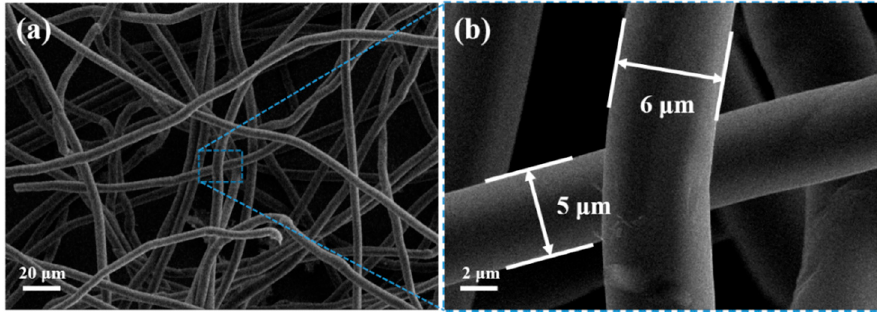
Figure 2. ( a ) and ( b ) SEM images of the BCF substrate.